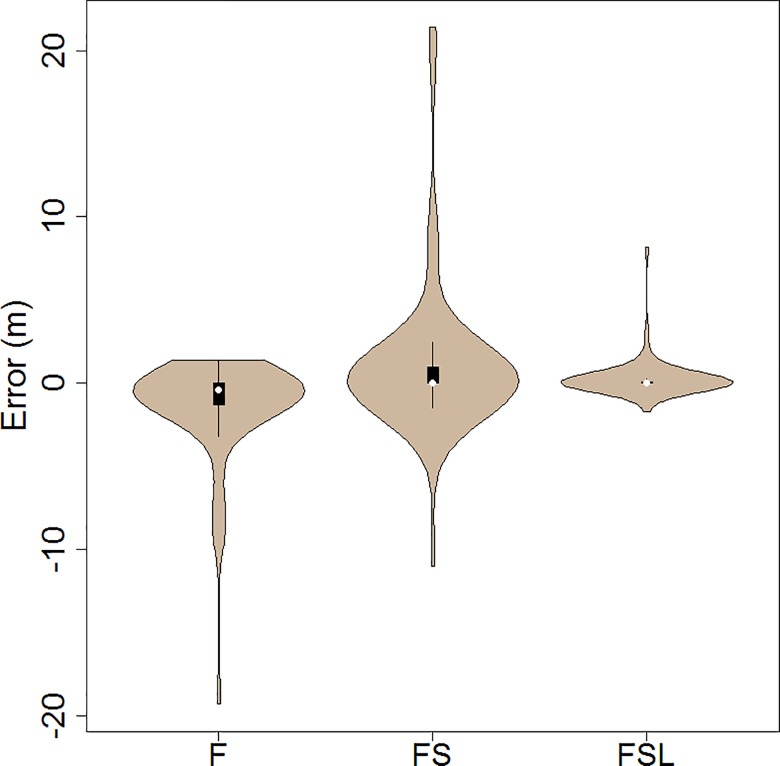
Violin plots showing error in flame height prediction for 58 plots modelled using three treatments of the FFM.As per [58], the box plots indicate data range, quartiles, and median, and the shaded area shows the density trace.